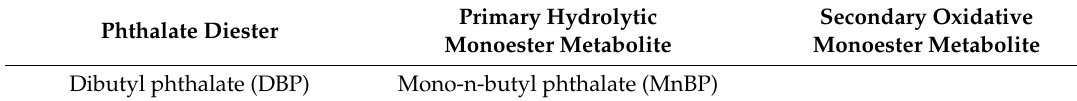
Table 3. Phthalate diesters and corresponding urinary phthalate metabolites.